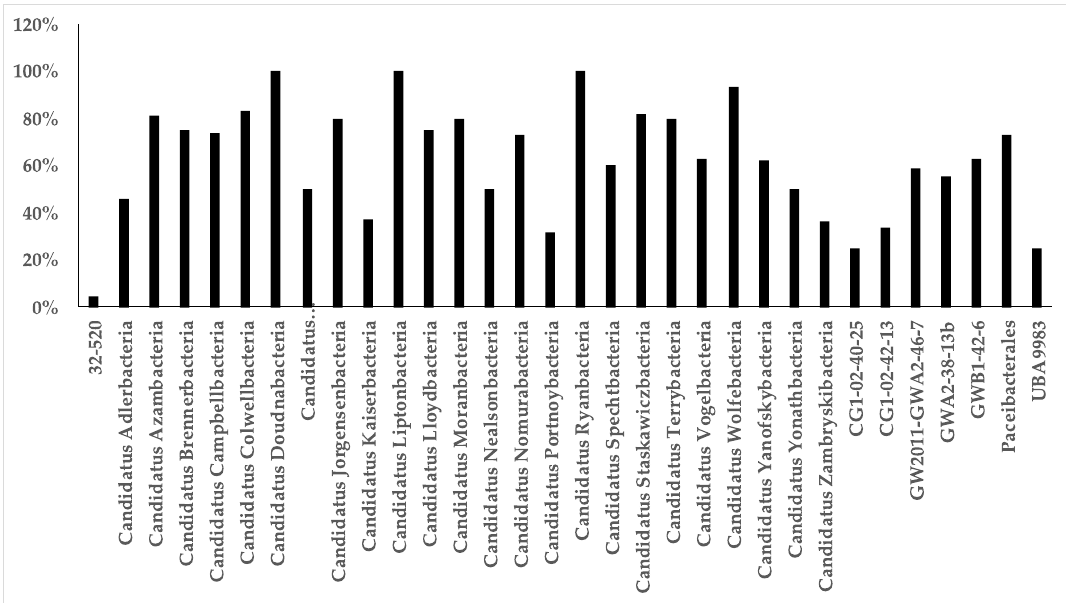
Figure A2. Coverage of primer set Bakt_341F/805R for various Cand. Parcubacteria clades (based on SILVA 138).